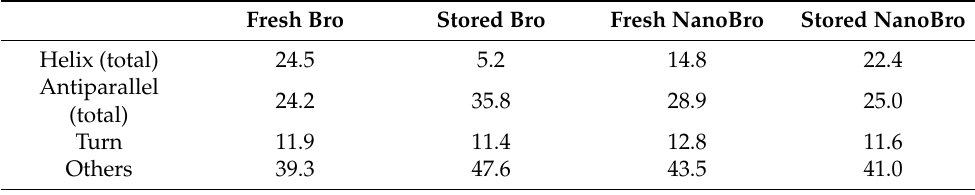
Table 1. Summary of the estimate of the percentage of secondary structures found in Bromelain under various experimental conditions according to data obtained by Circular Dichroism and analyzed by BeStSel. Fresh Bro Stored Bro Fresh